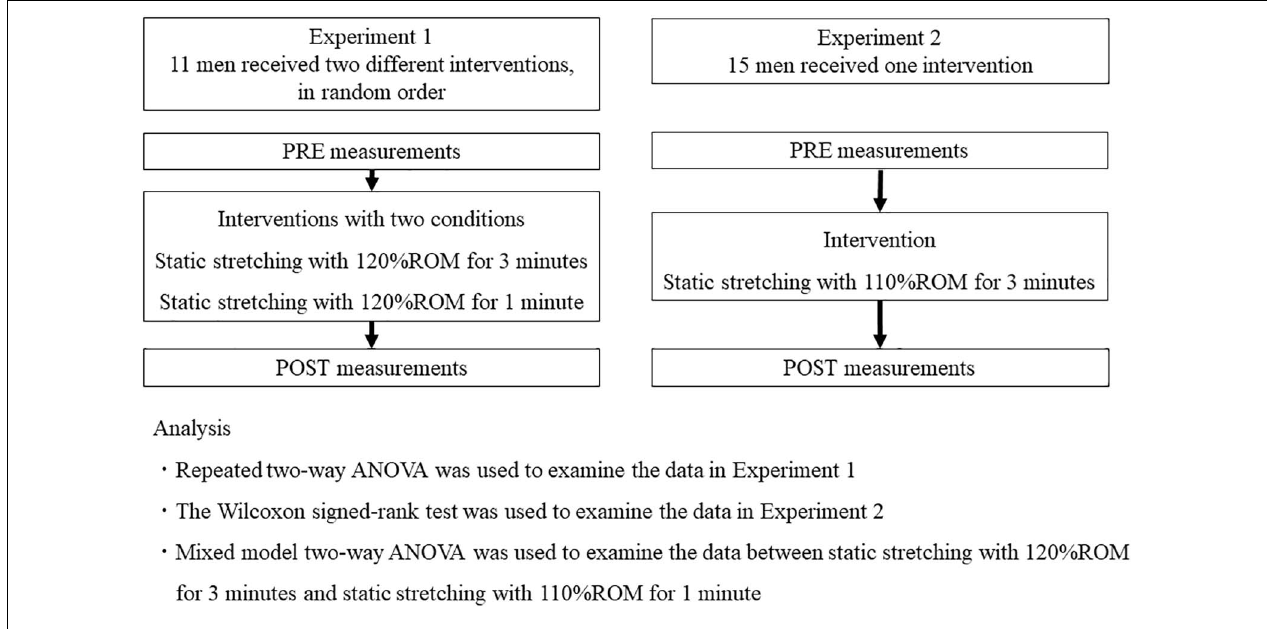
FIGURE 1 | Experimental design. ROM, range of motion; ANOVA, analysis of